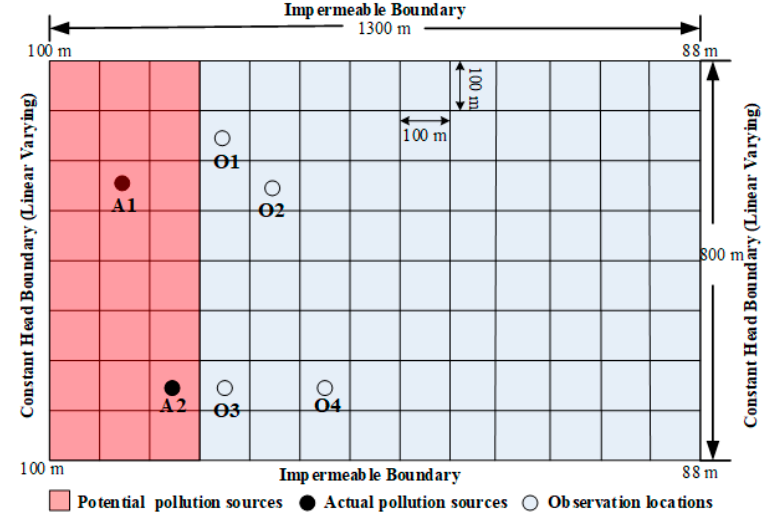
Figure 8. Distribution of potential pollution sources, actual pollution sources, and observation locations.